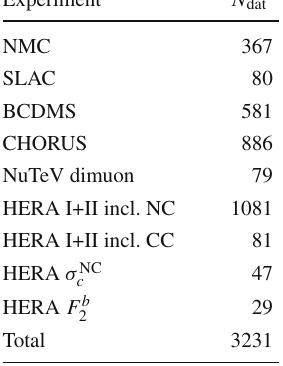
Table 1 The number of data points N dat for each of the DIS experiments included in